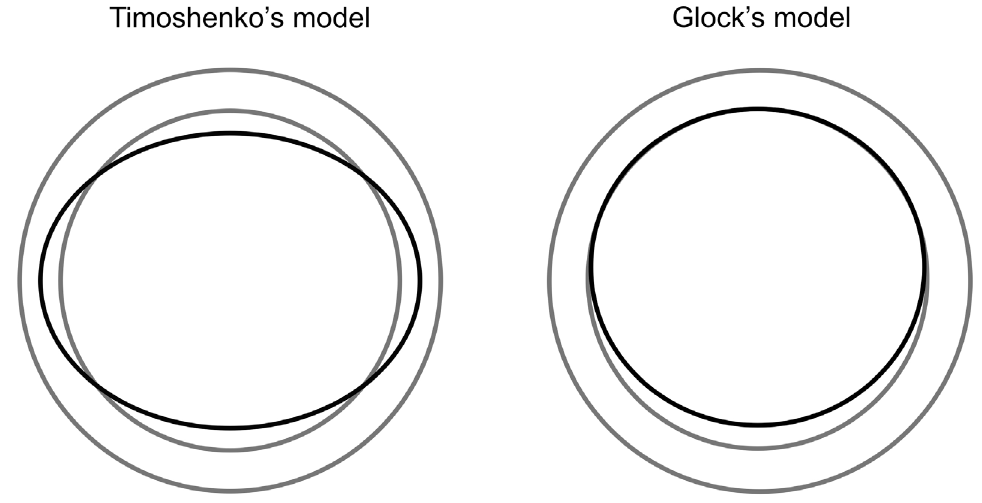
Figure 2: Computational models [11, 12].